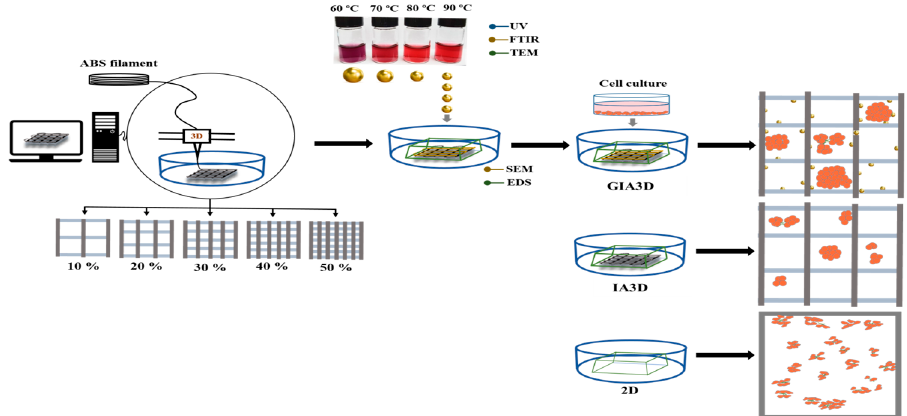
Figure 1. Schematic diagram of the experimental method. The 3D scaffold patterns were designed using a computer with NewCreatork program (version 1.57.41) for 3D printers. Industrial acrylonitrile butadiene styrene (ABS) white filament (1.75 mm) was inserted in the extruder feed throat of a 3D bioprinter and heated at 250 °C in the chamber. The scaffold was printed layer-by-layer via the fused deposition modeling technique into a 60-mm format Petri dish. A 3D